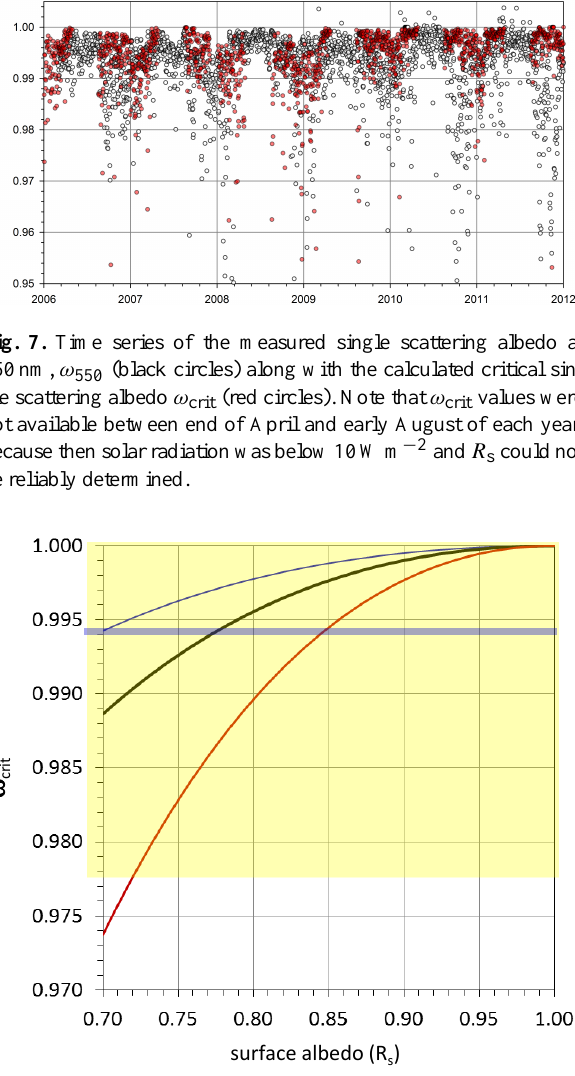
Fig. 8. Critical single scattering albedo ω crit as a function of sur- face albedo R s typically found at NM; ω crit is calculated for the mean (black line), maximum (blue line) and minimum (red line) hemispheric backscattering fraction measured by nephelometer at 550nm. The yellow shaded region represents the 5% to 95% per- centile range, the grey solid line the median of the measured ω 550